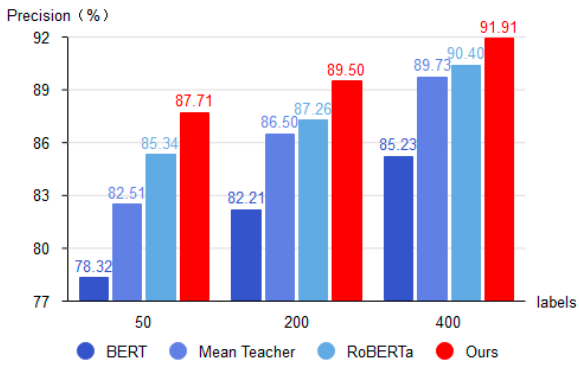
Figure 4. Precision results for the IMDb dataset.